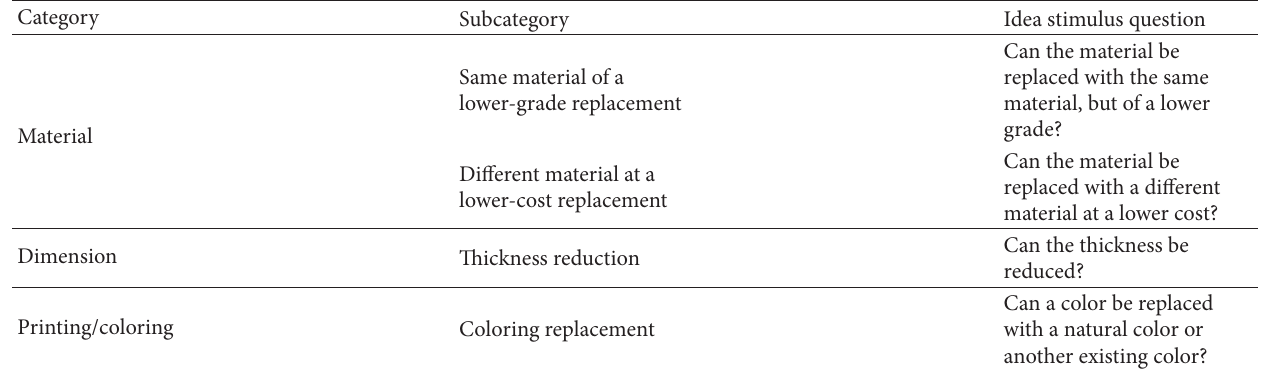
Table 11: Four subcategories for handset cases.